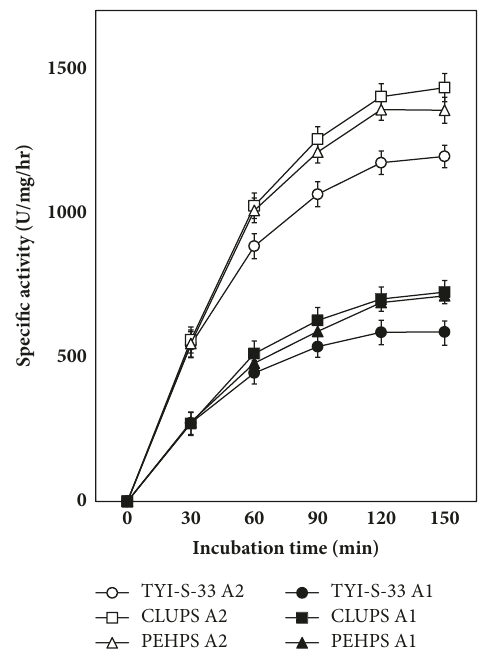
Figure2:PhospholipaseA1(A1)andphospholipaseA2(A2)activity of P30 trophozoite fractions as a function of time. E. histolytica trophozoites were grown in PEHPS, TYI-S-33, or CLUPS; mean ± SD of quintuplicated